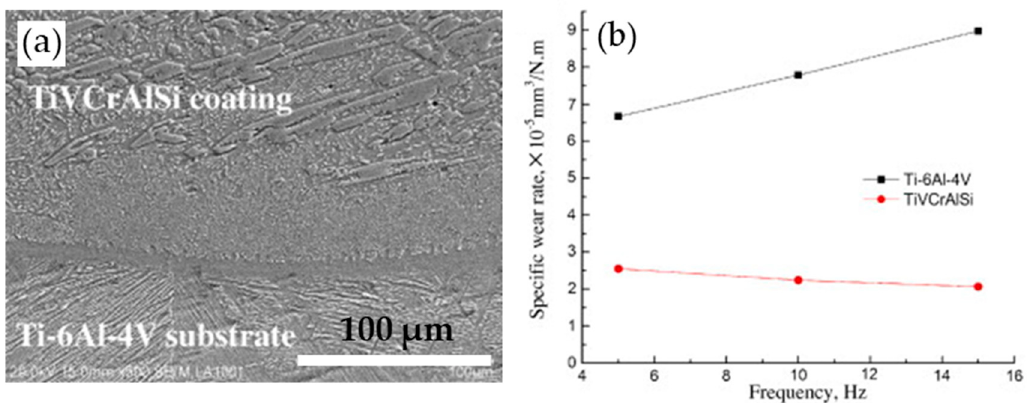
Figure 33. ( a ) SEM micrograph of AlCrSiTiV CCA coating on Ti-6Al-4V substrate and ( b ) specific wear rate of two materials after dry sliding wear test under various frequencies [97] (reprinted with permission from Elsevier).